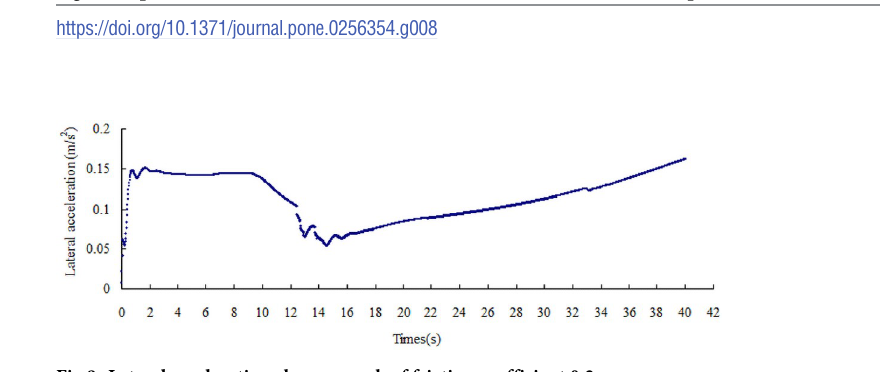
Fig 8. Graph between lateral acceleration and coefficient of friction of sideslip.